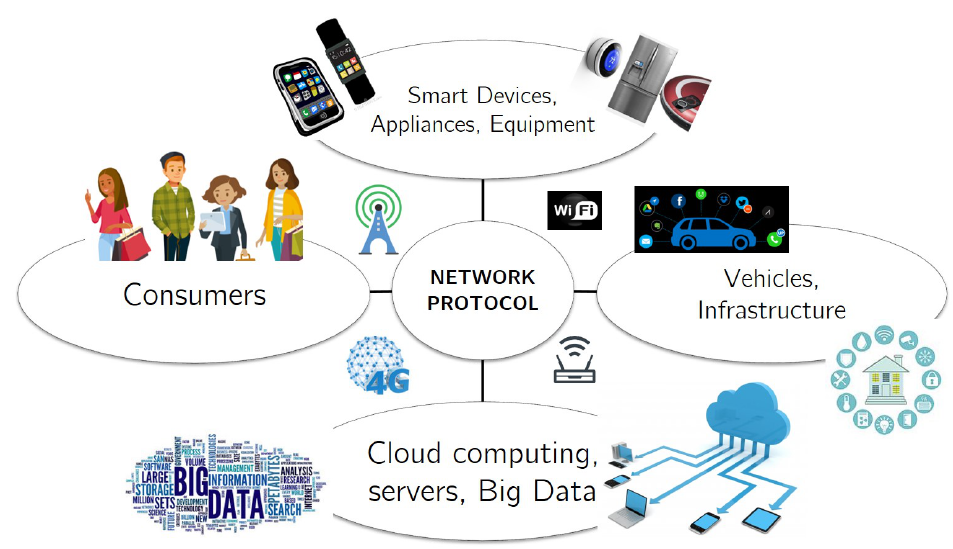
Figure 1. IoT Environment [4].